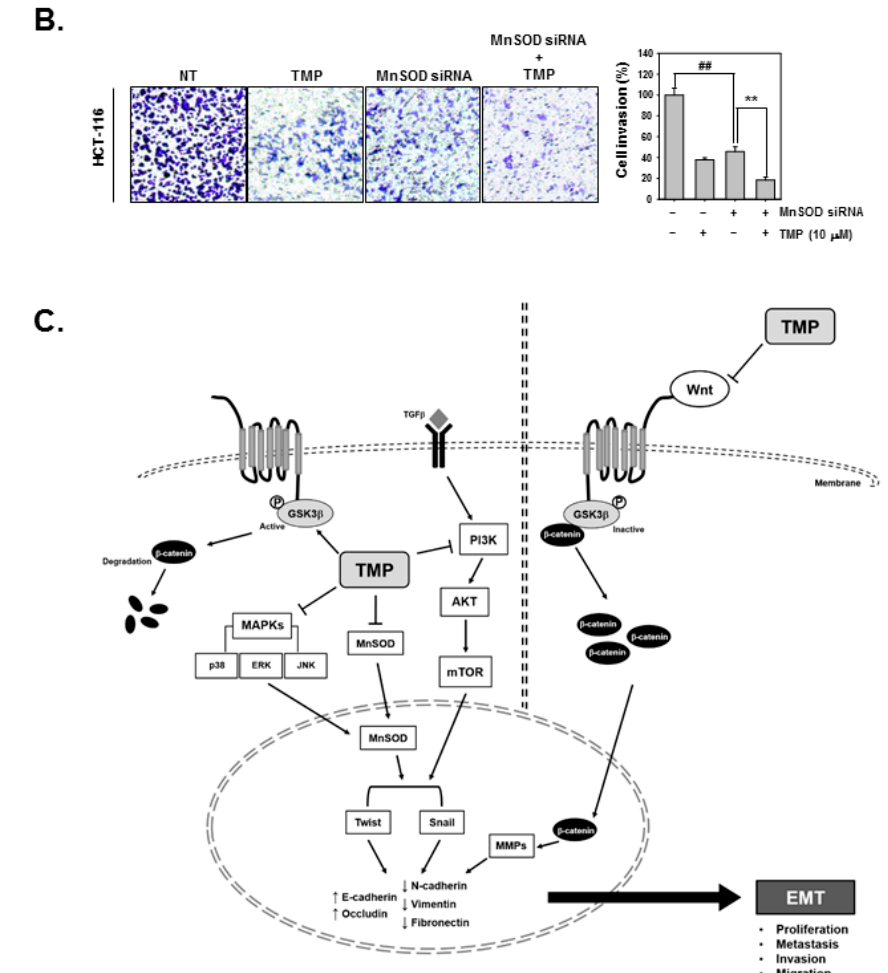
Figure 5. Effects of TMP and MnSOD knockdown on invasion and migration in HCT-116 cells. HCT- 116 cells (5 × 10 4 cells/well) were transfected with MnSOD siRNA for 24 h. ( A ) Then, the cells were treated with TMP (10 μ M) for 24 h. Indicated EMT markers were evaluated by Western blot analysis. ( B ) Invasion activity of MnSOD knockdown cells was evaluated by Boyden chamber assay. The cells were incubated for 5 h and stained in blue for observation. ( C ) Schematic diagram of TMP in HCT-116 cells. All the experiments were repeated at least thrice independently. ## p < 0.01 vs. non-treated (NT) cells, and ** p < 0.01 vs. MnSOD siRNA transfected cells.